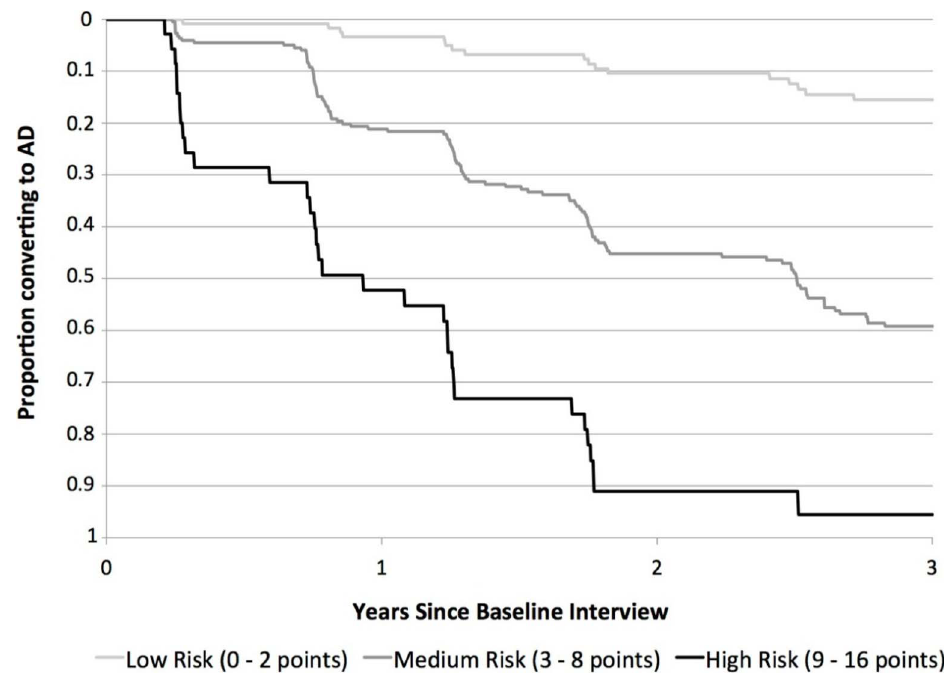
Fig. 2. Proportion of Subjects with Amnestic MCI Who Converted to AD in Low, Medium and High Risk Groups. Fourteen percent of subjects with low risk scores (upper line, 0–2 points, n 5 124) progressed from amnestic MCI to AD over three years compared to 51% of those with moderate risk scores (middle line, 3–8 points, n 5 223) and 91% of those with high risk scores (lower line, 9–16 points, n 5 35).